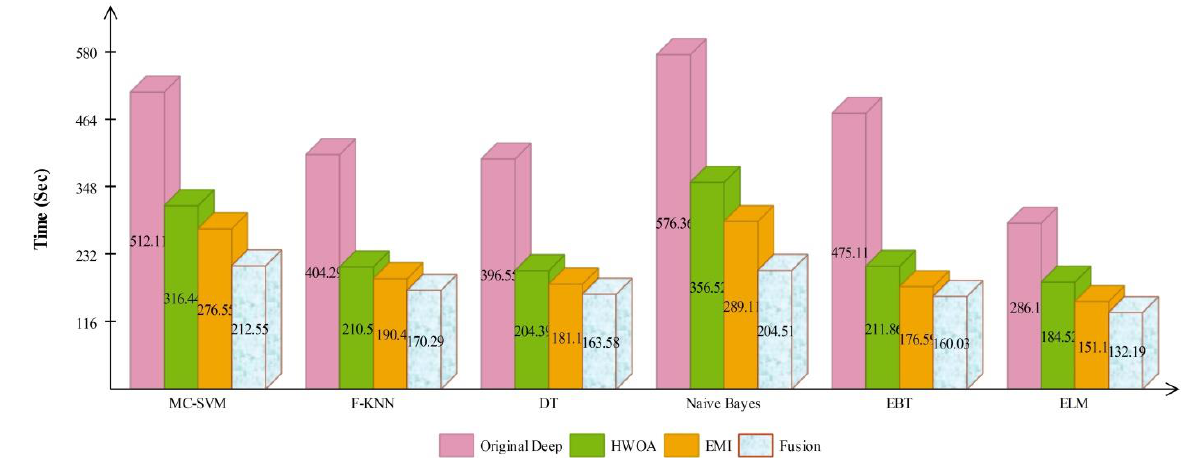
Figure 12. Computational time based comparison among middle steps for ISIC2018 dataset.